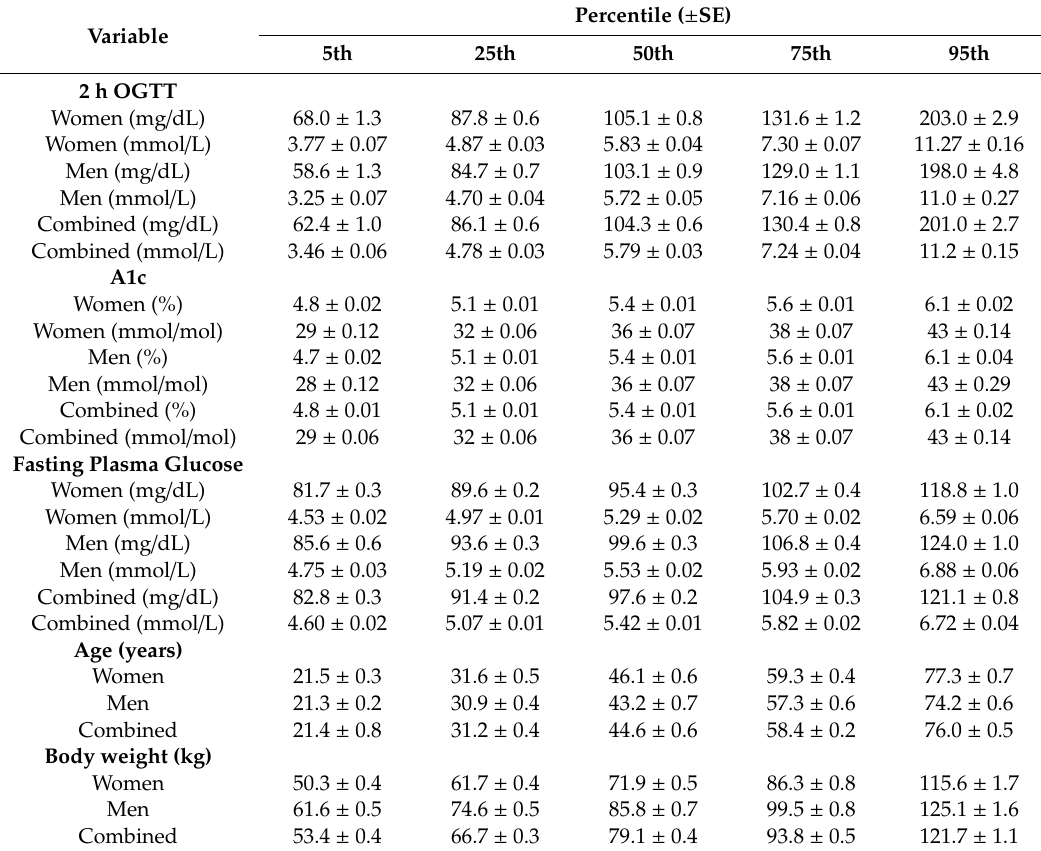
Table 1. Percentiles with standard errors for continuous variables in U.S. women ( n = 3809) and men ( n = 3603), and combined data ( n =